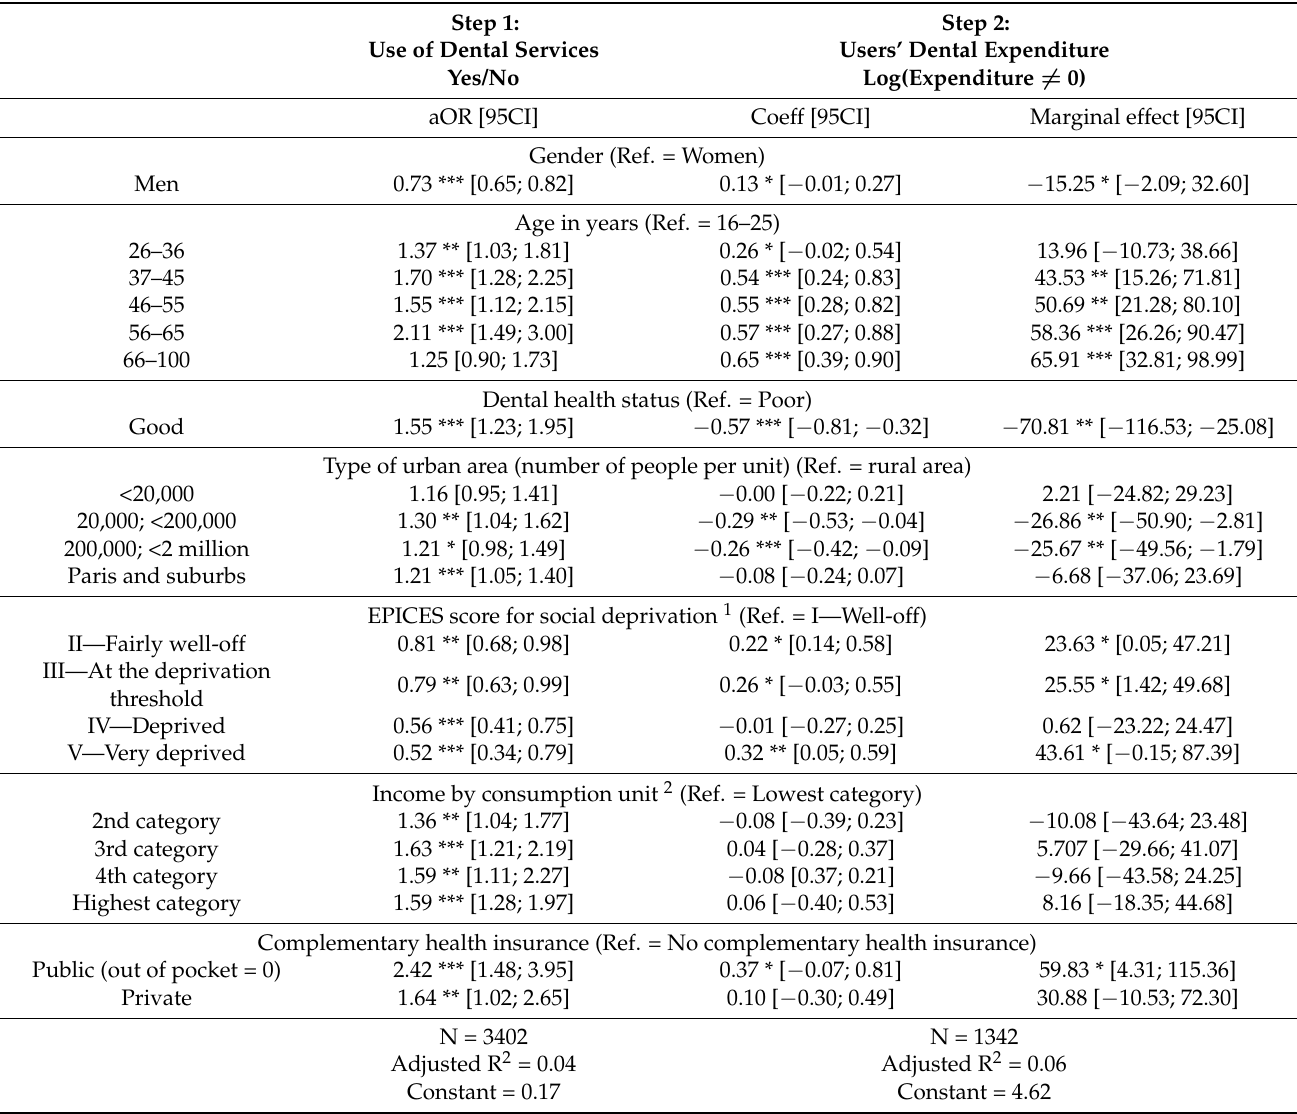
Table 2. Results for logistic regression analysis of primary access and linear regression analysis for secondary access (with marginal effects).